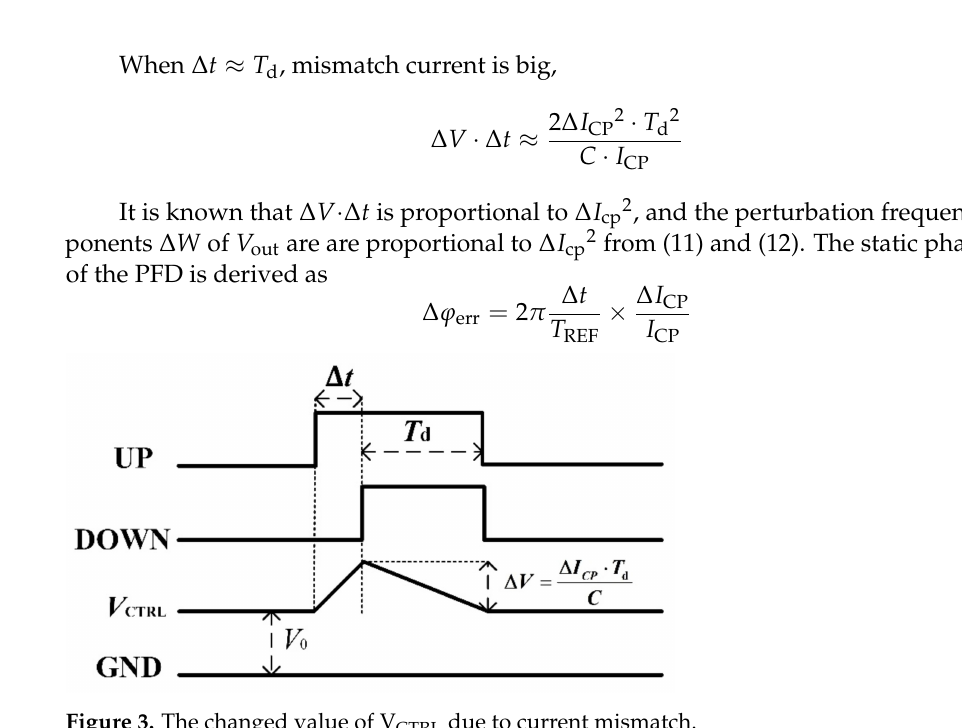
Figure 3. The changed value of V CTRL due to current mismatch.